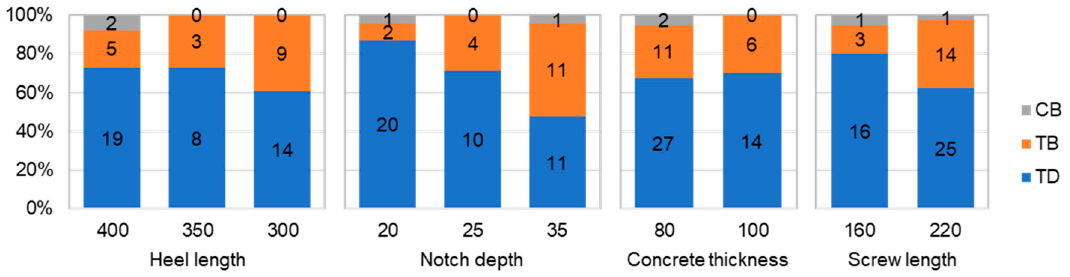
Figure 14. Number of specimens with different failure types .